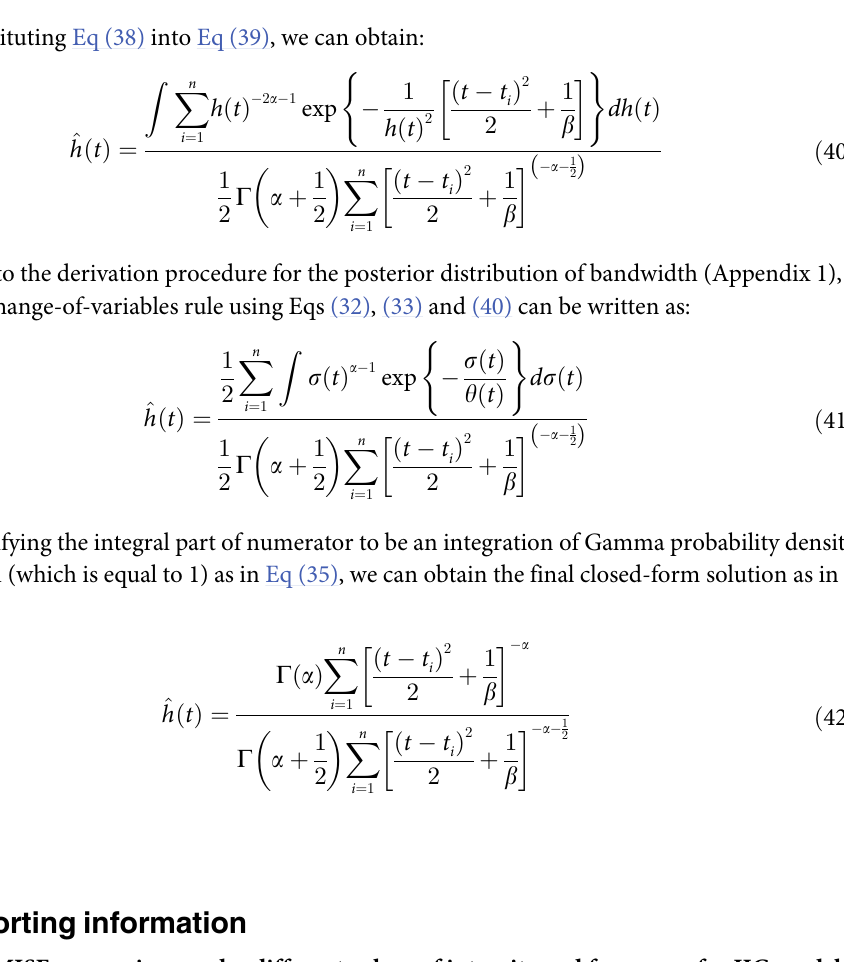
S1 Fig. MISE comparison under different values of intensity and frequency for IIG model. (a) MISE comparison for the case of low intensity. (b) MISE comparison for the case of high intensity. (c) MISE comparison for the case of low frequency. (d) MISE comparison for the case of high frequency. In each boxplot, black lines show the medians; black circles indicate the means; colored solid boxes represent interquartile ranges; whiskers extend 1.5 × from upper and lower quartiles; gray crosses represent outliers. S2 Fig. MISE comparison under different values of shape parameter ( γ = {0.25, 0.5, 0.75}). (a)-(c) MISE comparison for chirp, sine, and sawtooth rate functions, respectively, from IG model. (d)-(f) MISE comparison for chirp, sine, and sawtooth rate functions, respectively, from IIG model. Vertical bars represent the 95% confidence intervals. S3 Fig. MISE comparison for IIG model with Gaussian-damped sinusoidal rate function. In each boxplot, black lines show the medians; black circles indicate the means; colored solid boxes represent interquartile ranges; whiskers extend 1.5 × from upper and lower quartiles; gray crosses represent outliers. S4 Fig. Firing rate estimate comparison for IIG model with Gaussian-damped sinusoidal rate function. (a)-(c) Firing rate estimates for the cases of low, medium and high